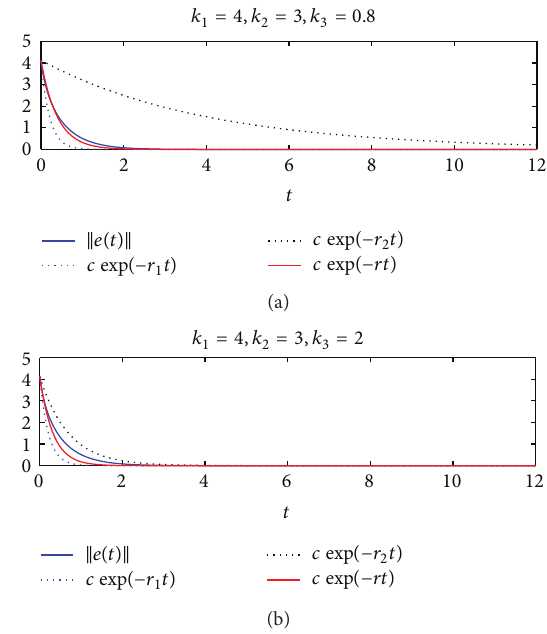
Figure 4: Comparison of the proposed “rate” curves with ‖𝑒(𝑡)‖ for synchronization using the hybrid control technique ( 𝑐 = ‖𝑒(0)‖ ).